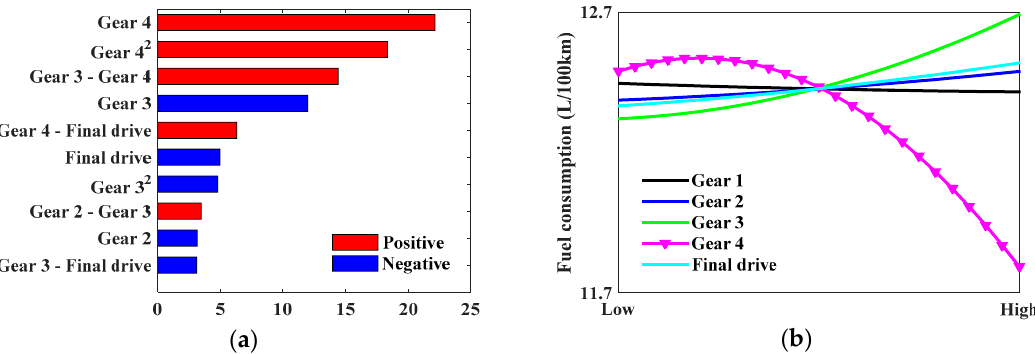
Figure 10. Response (fuel consumption). ( a ) Effect on fuel consumption (%); ( b ) Main effect.